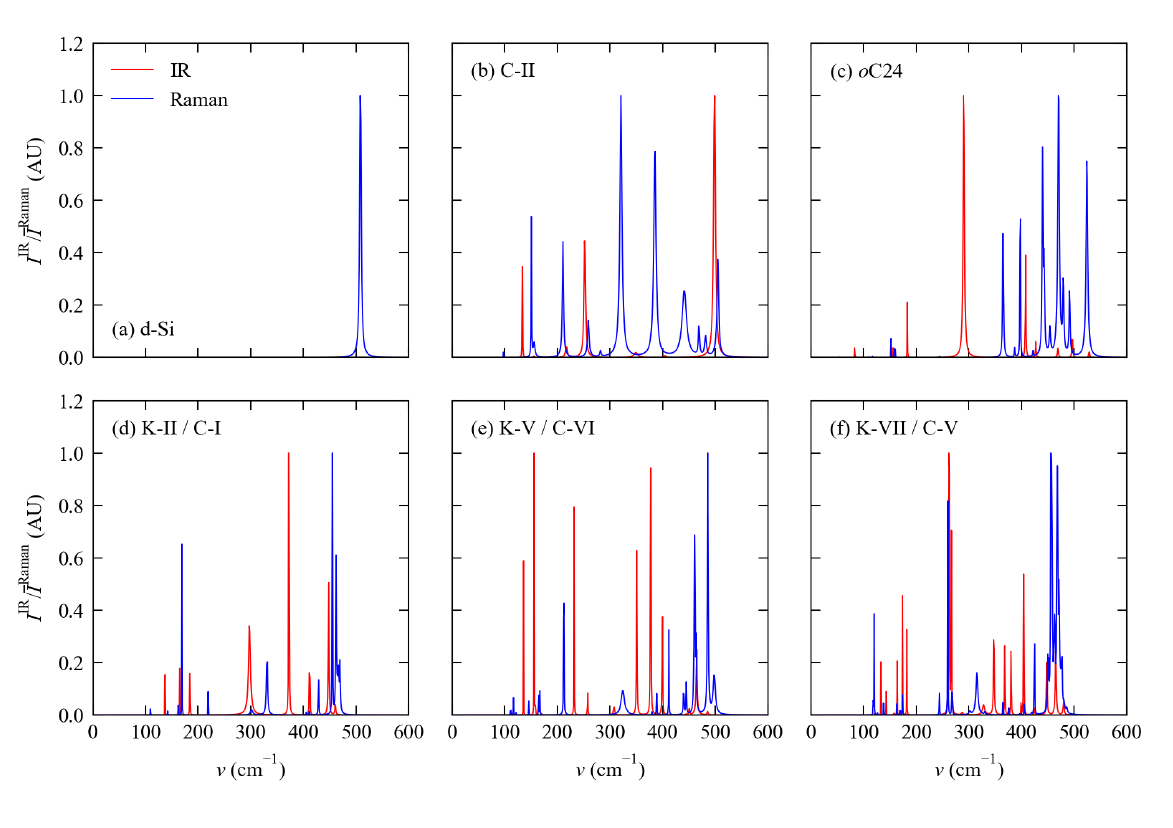
Figure 4. Simulated infrared (IR; red) and Raman (blue) spectra of the six structures examined in this work obtained using the method in Ref. [52]: ( a ) d-Si, ( b ) C-II, ( c ) o C24, ( d ) K-II/C-I, ( e ) K-V/C-VI, and ( f ) K-VII/C-V. The Raman activities used to generate these spectra are the scalar averages I Raman defined in Equation (6). Table 3. Analysis of the 3 N Γ -point phonon modes in the six structures examined in this work. For each structure we list the irreducible representation Γ 3 N spanned by the modes together with the expected numbers of infrared (IR)- and Raman-active modes based on